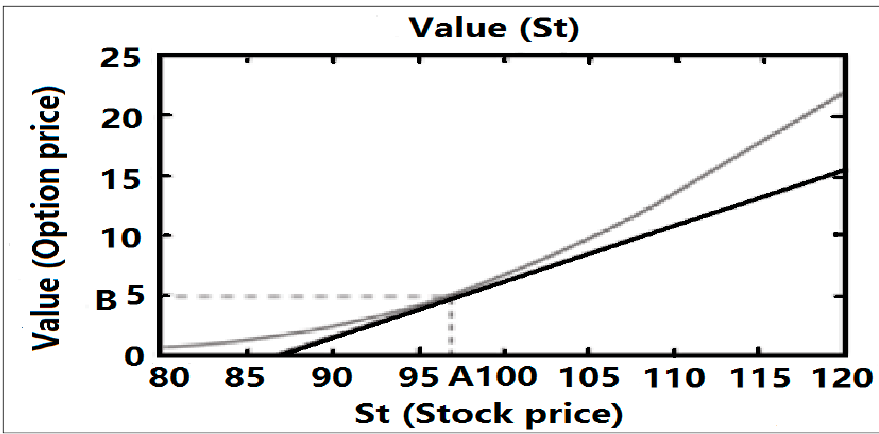
Figure 7. Calculation of Delta.